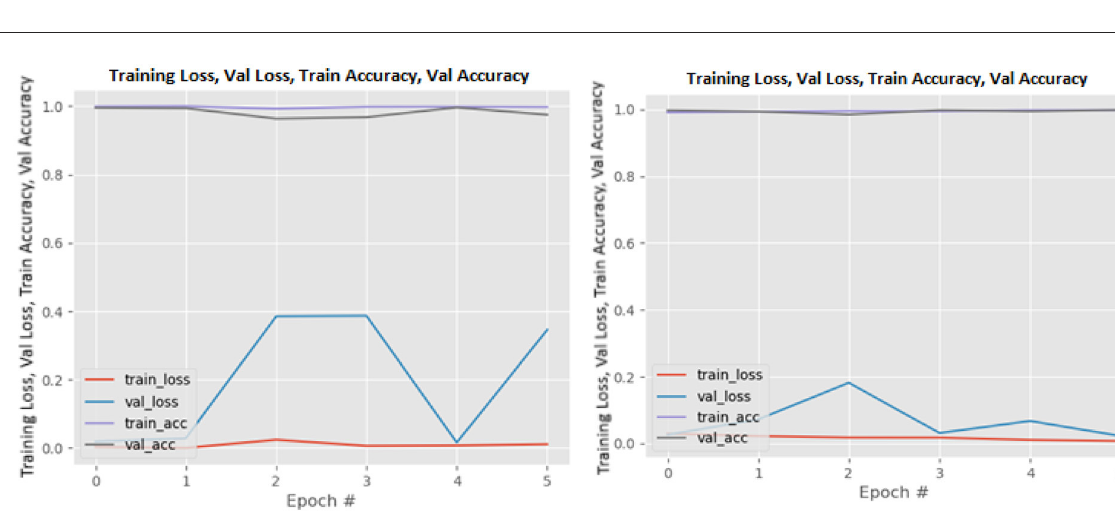
FIGURE14 NASNetLarge without data augmentation (left image) and with data augmentation (right